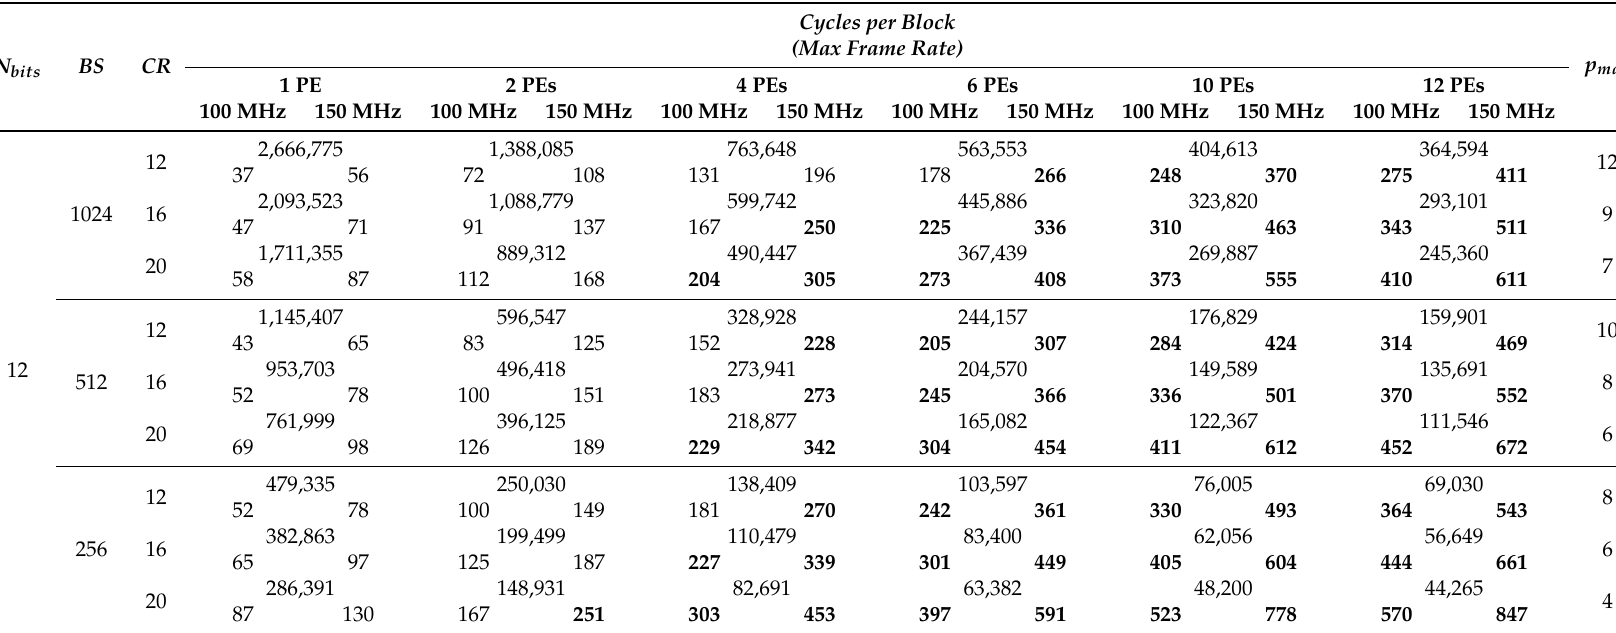
Table A1. Evaluation of the results obtained using the FPGA-based solution on a Xilinx Zynq-7020 programmable SoC for hyperspectral images with 180